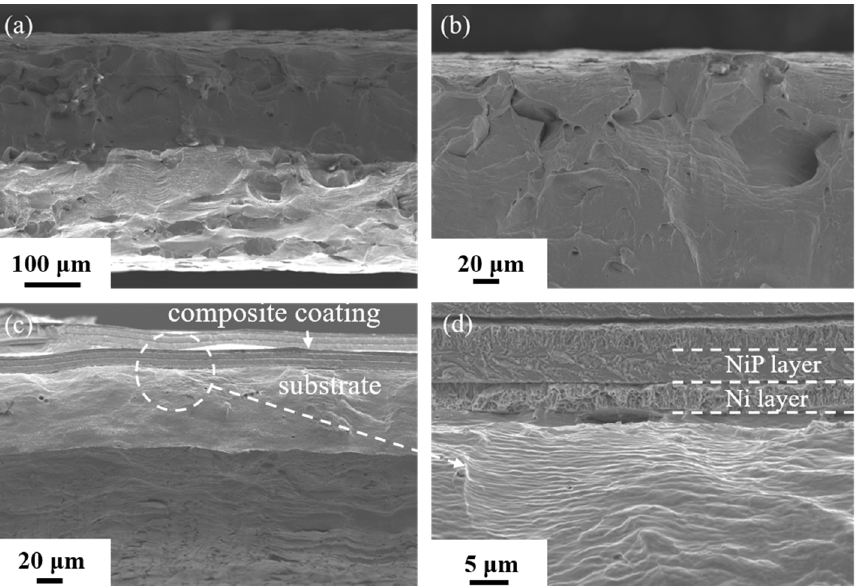
Figure 4. SEM images of tensile fracture surfaces of samples with and without coatings: ( a ) Ni substrate without coating; ( b ) The upper part of the substrate without coating; ( c ) The CG Ni substrate with NiP/Ni composite coating; ( d ) Enlarged view of the white circle in ( c ).